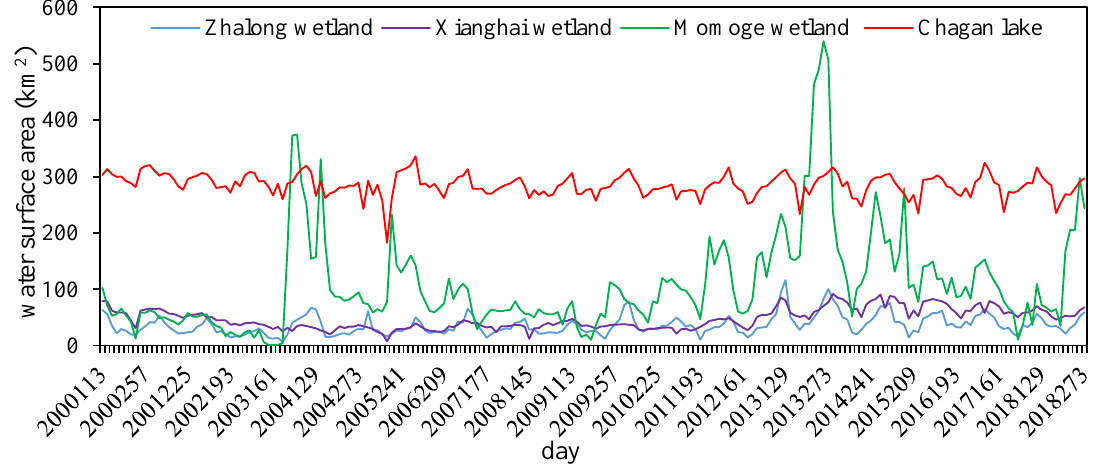
Figure 12. Fluctuation of water surface areas in Zhalong, Xinghai, Momoge, and Chagan in the Nenjiang River Basin, Northeast China, during the past 19 years.